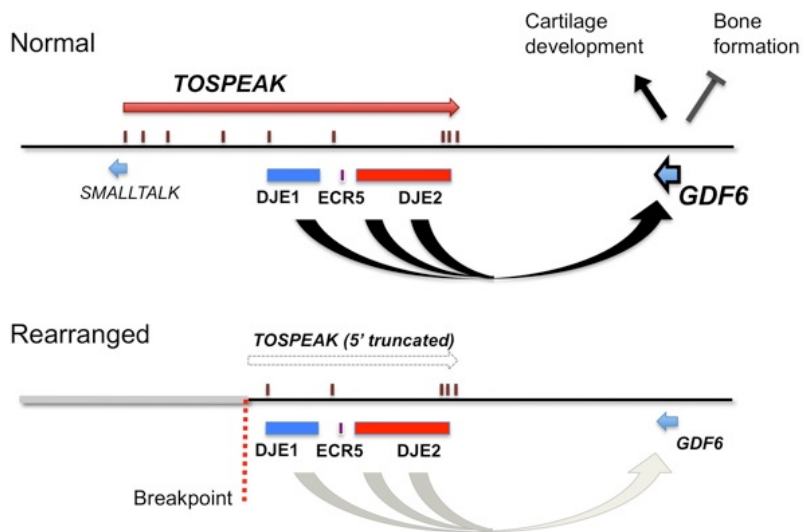
Figure 10. Mechanistic modelling of the SMALLTALK-TOSPEAK-GDF6 overlapping speech gene complex before and after disruption of the TOSPEAK gene in the speech impaired